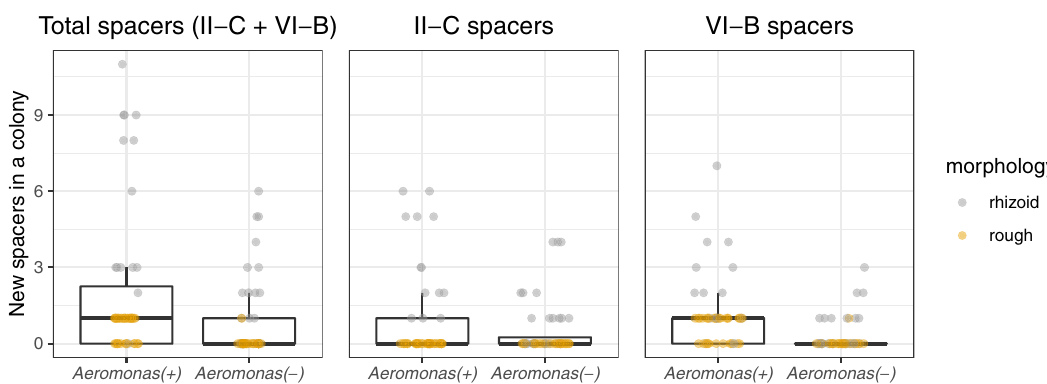
Fig. 6 Effect of competitor on CRISPR-Cas spacer acquisition. The Y-axis shows the total number of spacers in a single F. columnare colony in the presence or absence of Aeromonas sp . The box plots capture the minimum and maximum values, 25th and 75th percentile (box) and the median (black horizontal line). Source data are provided as a Source Data fi